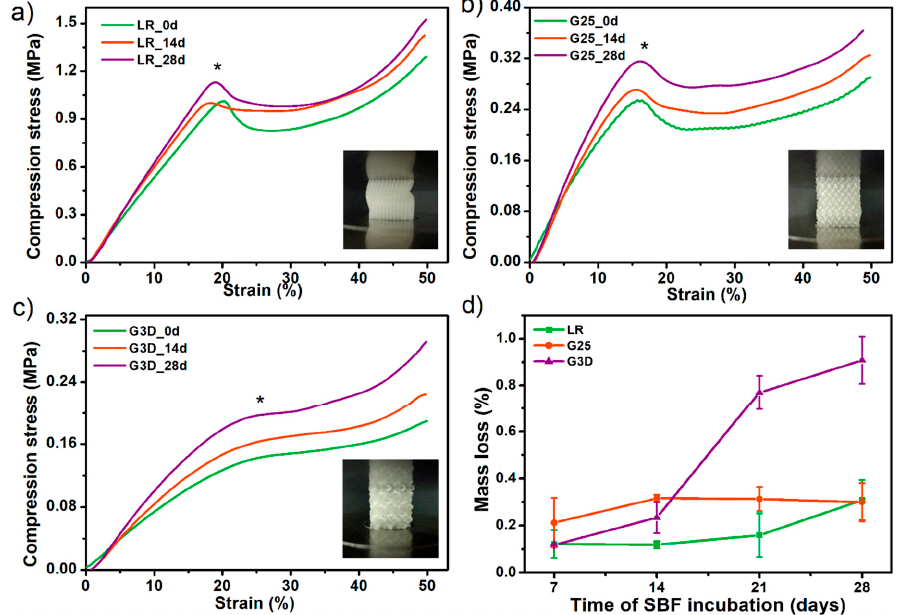
Figure 10. The influence of incubation in simulated body fluid SBF solution on compressive strength ( a,b,c ) and mass loss ( d ) of selected porous tissue structures PTS. * The inflexion point of the stress-strain curves (the so-called Yield point) was assumed as the compressive strength values of studied PTS.